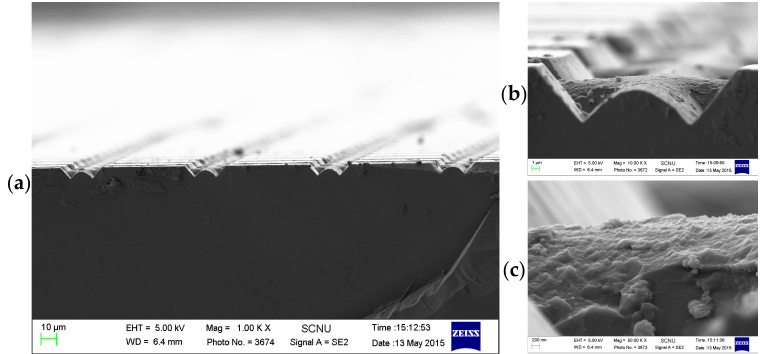
Figure 2. SEM images of a two-layer structures ( a , b ), and the residue substance on the wall-like structure surface ( c ). The pattern size was 75 μm × 75 μm with 5 μm gap distance. The substrate was etched in 10 wt % HF for 1.5 min, and then in 10 wt % KOH solution for 30 min at 70 °C.